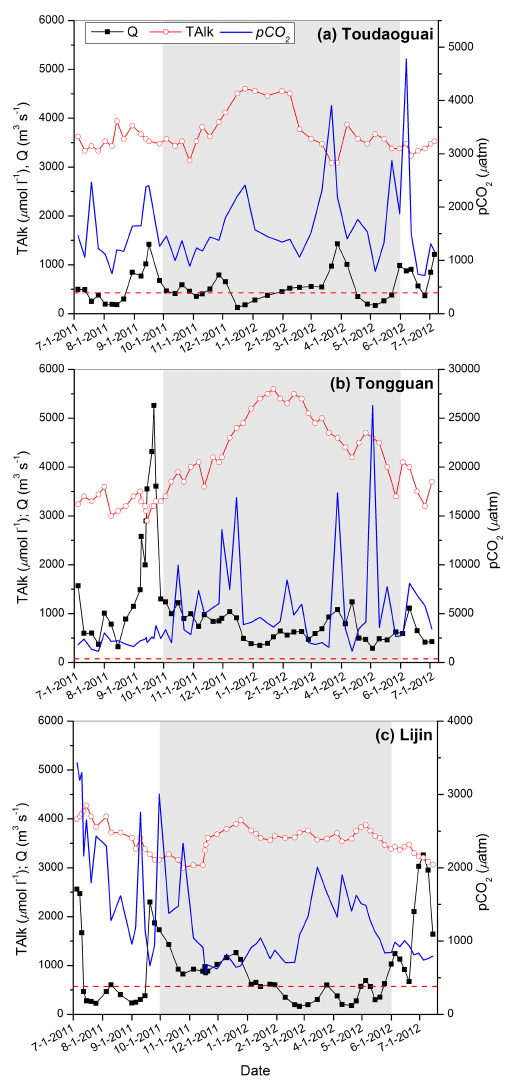
Figure 4. Weekly variations in water discharge ( Q ), TAlk, and p CO 2 at (a) Toudaoguai, (b) Tongguan and (c) Lijin from July 2011 to July 2012. The dotted line denotes the atmospheric CO 2 equilib- rium (i.e. 380µatm) and the shaded grey represents the dry season.